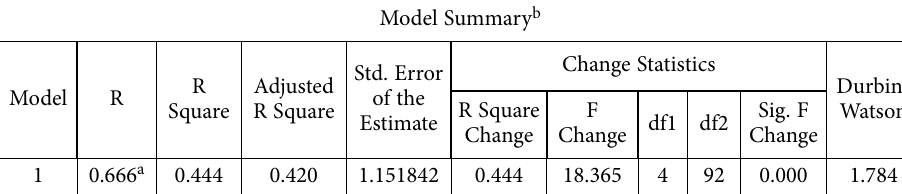
Table 4. Model summary and ANOVA (Europe) (source: own construction by using